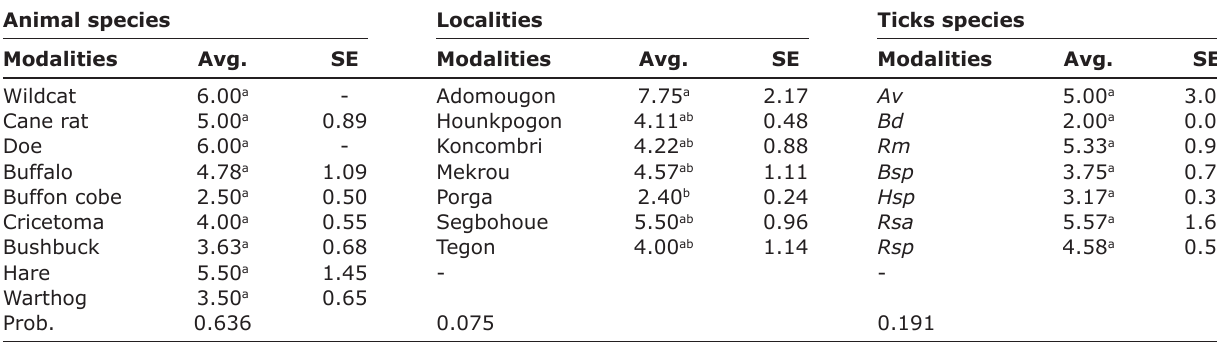
Table-2: Average number of ticks and standard error per factor. Animal